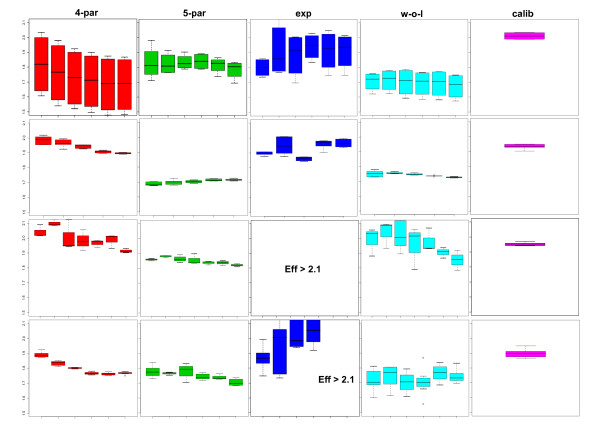
Assessment of quantitative real-time PCR efficiencies from the replicates of four independent dilution datasets. Four independent datasets (in rows) were analyzed in respect to the PCR efficiencies of five different methods (in columns), as follows: 4-par: a four-parametric log-logistic model; 5-par: a five-parameter log-logistic model; exp: an exponential model after outlier cycle detection [9]; w-o-l: the window-of-linearity method as described in [8]; calib: a calibration curve obtained from linear regression of all threshold cycles. The boxplots depict the statistical features of the replicates within each dilution step. For methods 1–4, efficiencies were calculated per curve, while for method 5 one efficiency estimation was obtained from all dilution steps. If estimated efficiencies were larger than 2.1, this is denoted in the graphs. The derivation of the efficiency from four- and five-parameter models was done with Equation 8.